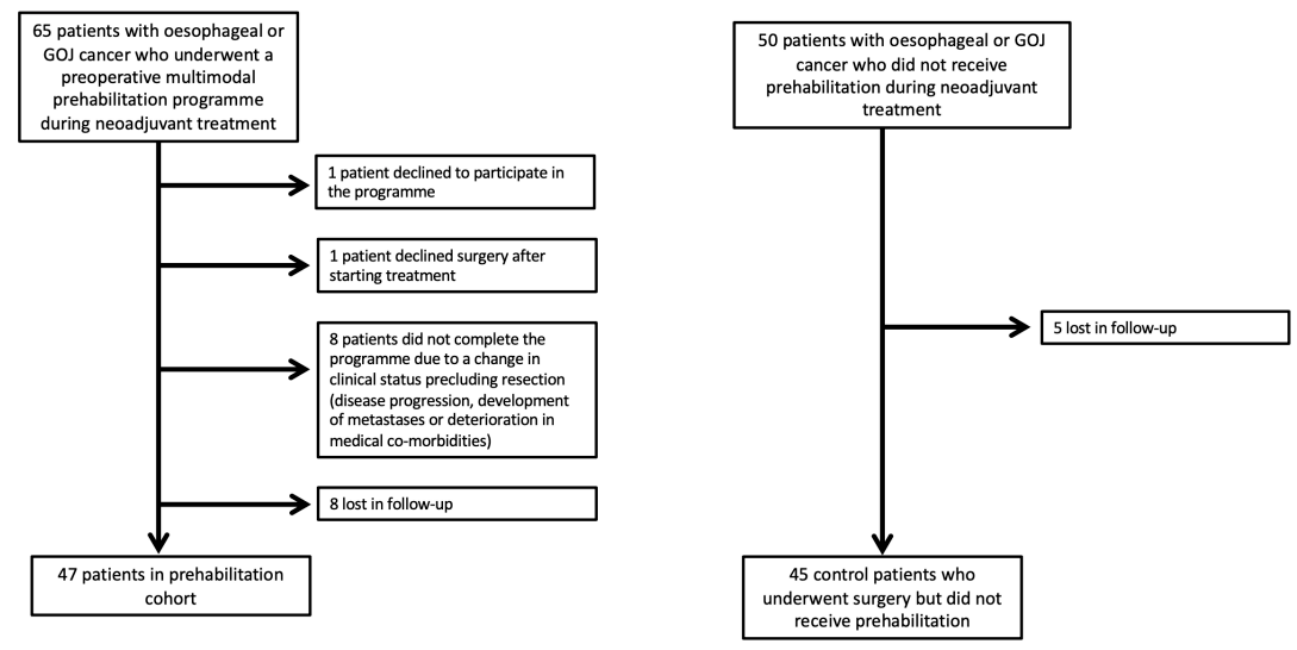
Figure 1. Study participant flow chart. Table 1. Patient baseline